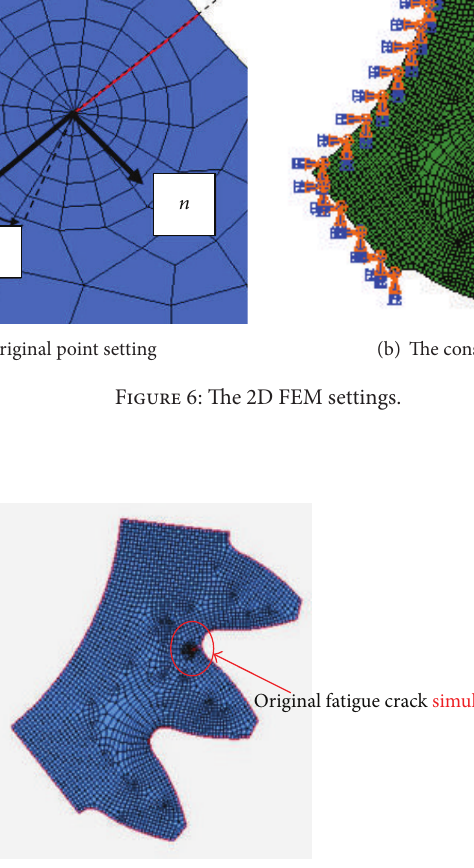
Figure 7: The simulation of the original fatigue crack of the example